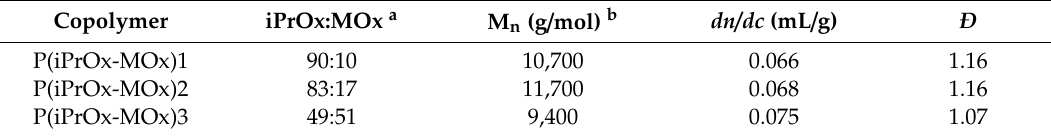
Table 1. Characterization data of the copolymers